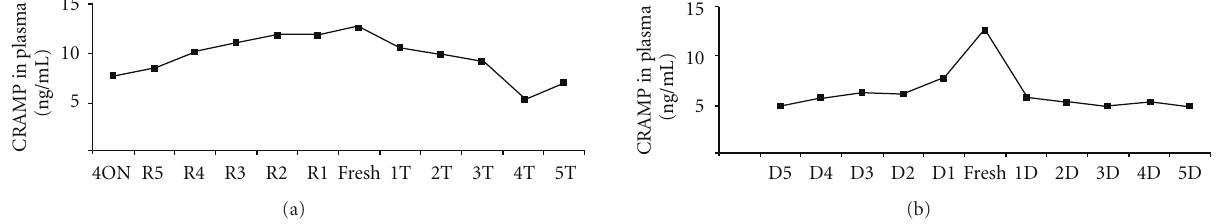
Figure 4: Standardization of ELISA for CRAMP. (a) The results show that the fresh plasma has the highest ELISA data, and the plasma kept in 4 ◦ C overnight or in the room temperature less than 3 hours, and the plasma thawed less than 3times have little lower data, but the statistics does not show the significant di ff erence. But the plasma kept in the room temperature more than 4 hours, thawed more than 4 times have the higher data, the statistics shows the significant di ff erence. (b) The results show that the fresh plasma has the highest ELISA data, and the plasma kept in 4 ◦ C over 1night, 2, 3, 4, 5 nights or in the room temperature for 1day 2, 3, 4, 5 days have much lower data, and the statistics show the significant di ff